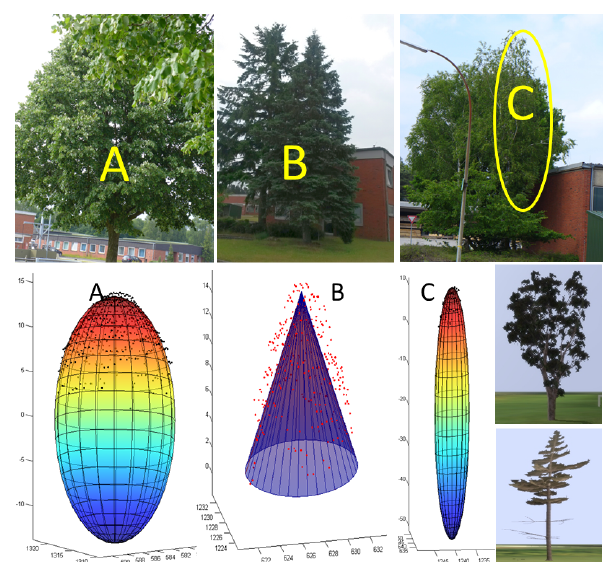
Figure 5: Top row: The first three images show selected trees which are approximated by conics as shown in the three images of the bottom row. Top right: Part of the DSM. Bottom right: Two prototypes for tree models.